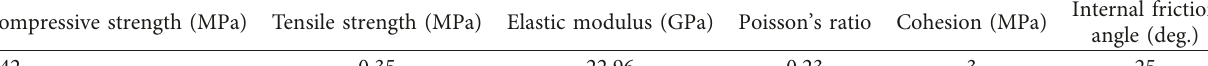
Table 1: Rock mechanics parameters in numerical simulation.